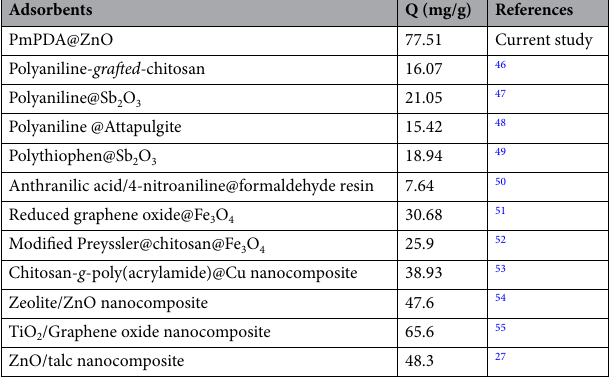
Table 3. Comparison of the maximum adsorption capacities of lead(II) by various adsorbents.